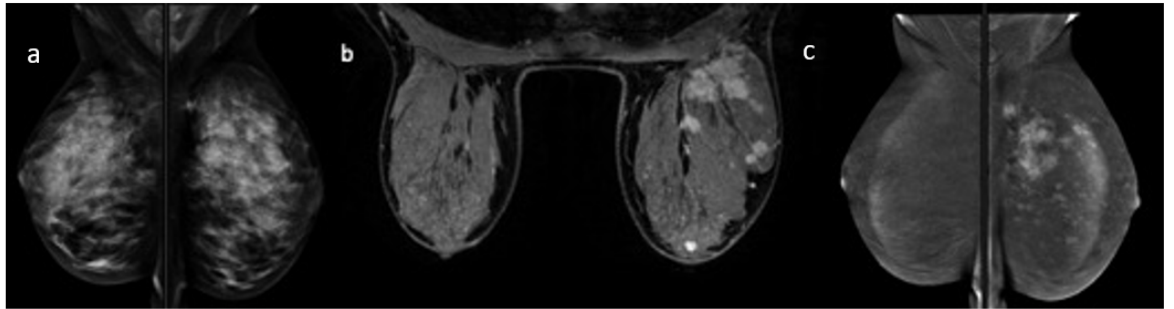
Figure 1. Local advanced breast cancer of the upper outer quadrant of the right breast; FFDM shows an area of hyperdensity ( a ); US confirmed a hypoechoic lesion ( b ), while MRI and CESM showed more extensive disease ( c , d ).